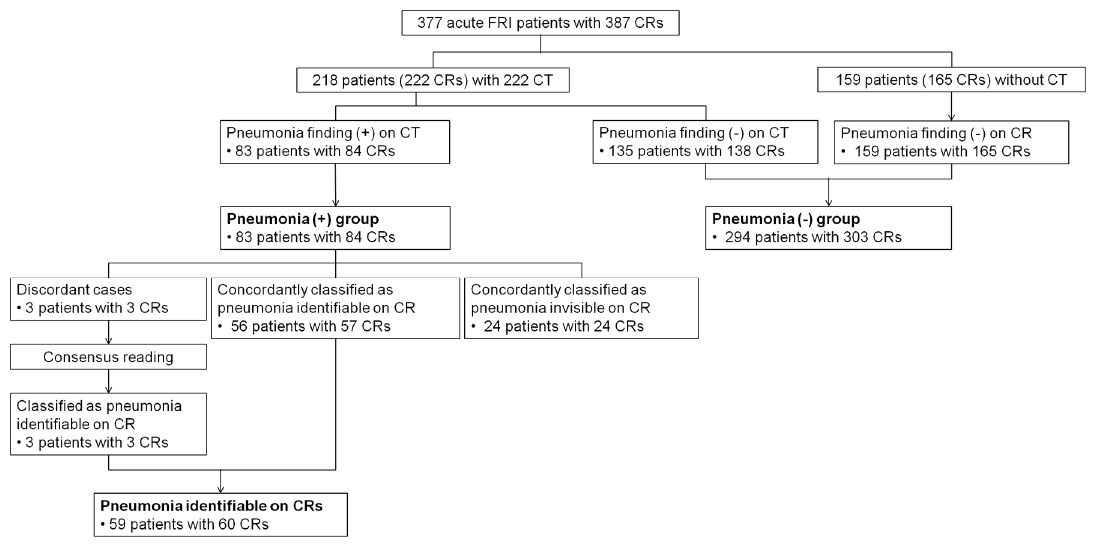
Figure 2. AUROCs of DL algorithm and ED physicians (pneumonia vs. non-pneumonia). ( a ) The DL algorithm showed significantly higher performance than that for ED physicians (0.861 vs. 0.788; P = 0.019). ( b ) ED physicians’ performance was improved after assistance with DL algorithm (0.788 vs.